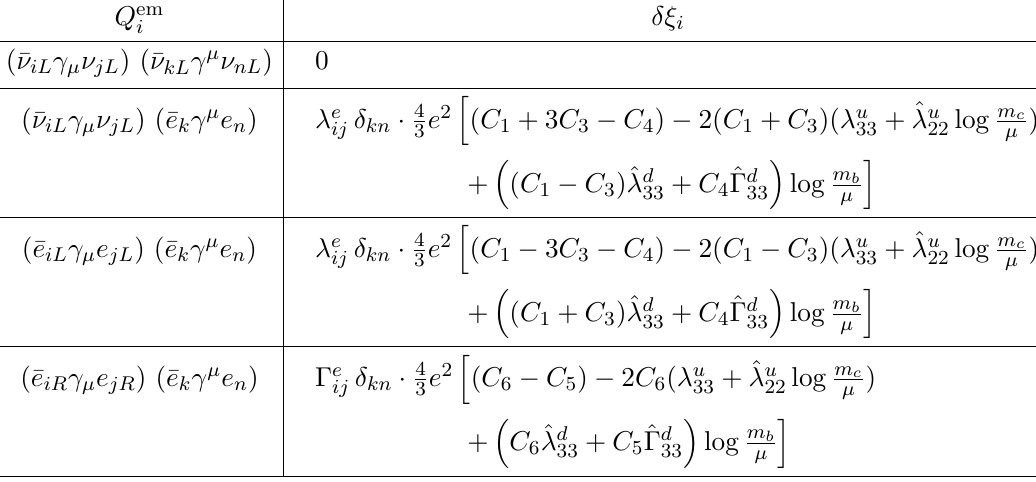
Table 6 . Operators Q em